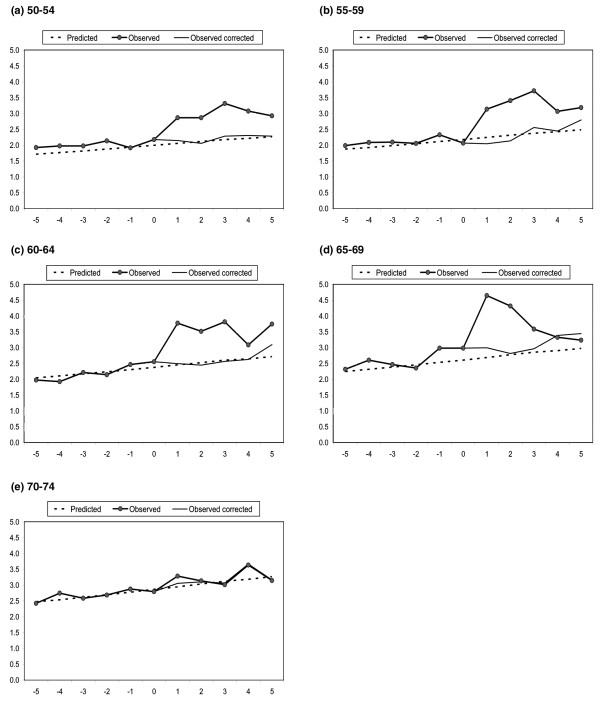
Breast cancer incidence rates predicted, observed, and observed corrected for lead time. The age groups at first invitation were as follows: (a) 50 to 54 years; (b) 55 to 59 years; (c) 60 to 64 years; (d) 65 to 69 years; (e) 70 to 74 years.